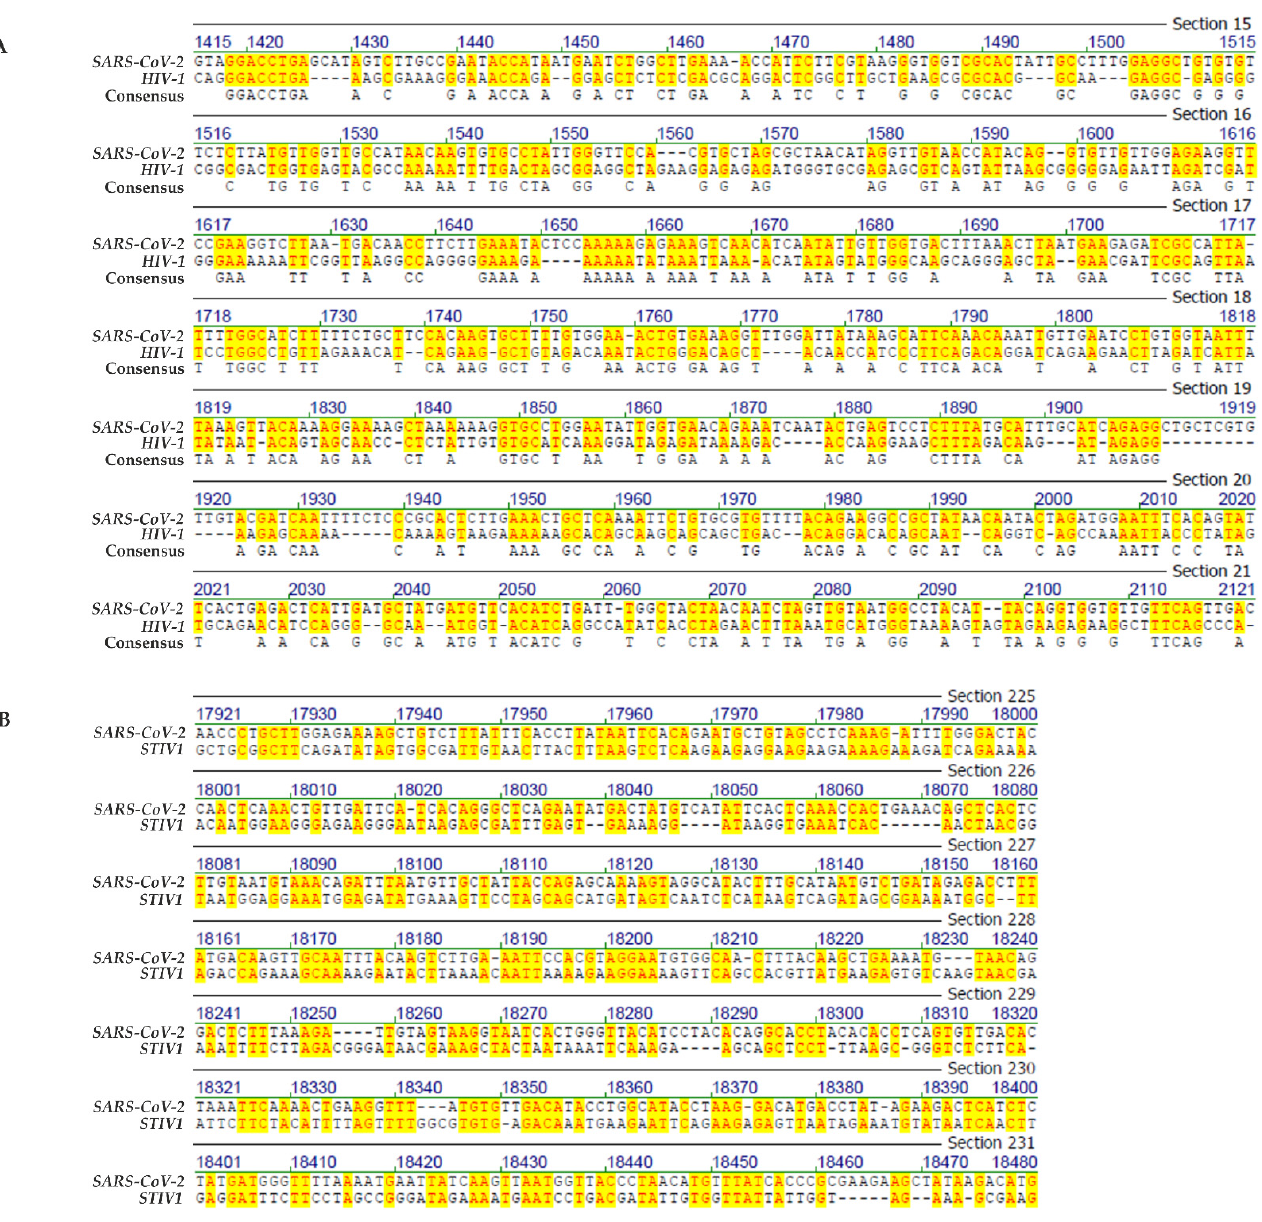
Figure 2. ( A ) Sequence alignment between Wuhan SARS-CoV-2 and HIV-1 . ( B ) Sequence alignment between Wuhan SARS-CoV-2 and Sulfolobus turreted icosahedral virus 1 ( STIV1 ). The yellow highlight designates sequence identities between the genomes of SARS-CoV-2 and HIV ( A ) and Sulfolobus turreted icosahedral virus ( STIV1 ) ( B ), respectively.